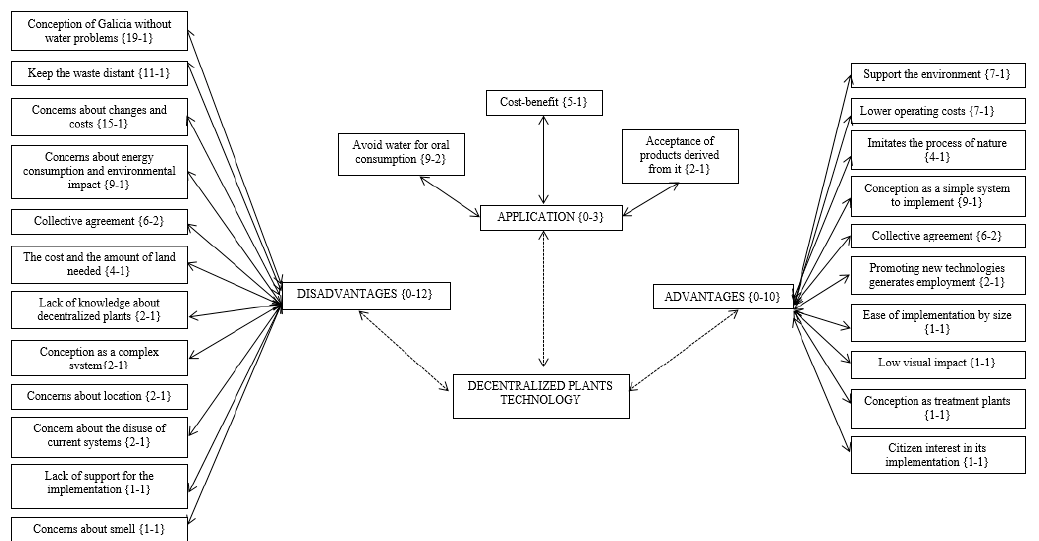
Figure 2. Summary table of the analysis carried out in Atlas.ti, which includes the recurring ideas from the focus groups. The table shows the triangulated data composed by three central categories: (1) advantages, (2) disadvantages and (3) application of decentralized wastewater treatment systems.